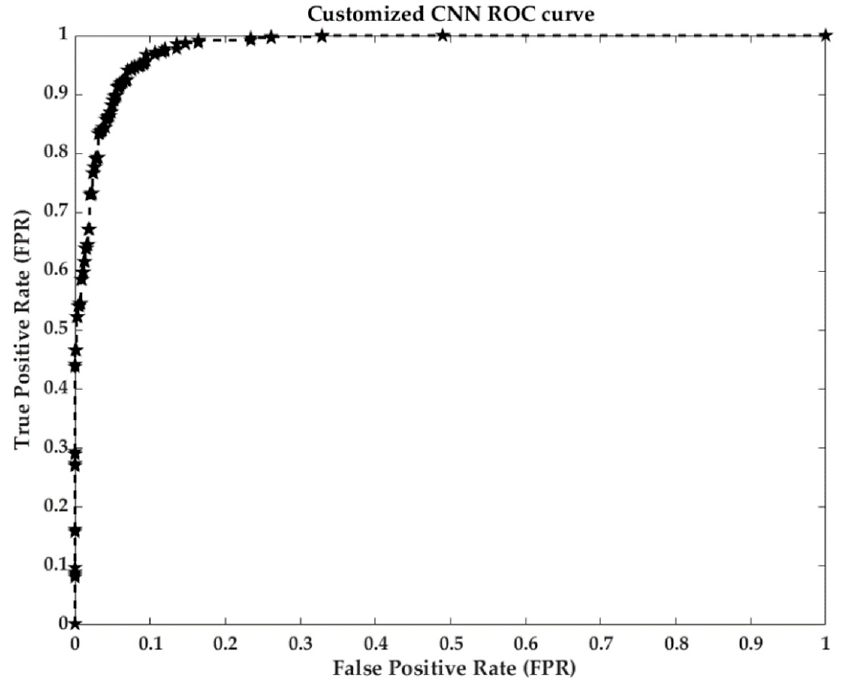
Figure 9. Receiver Operating Characteristic (ROC) curve of the proposed Customized CNN model. Table 4. Accuracy of the models at the 1st and 20th epoch.